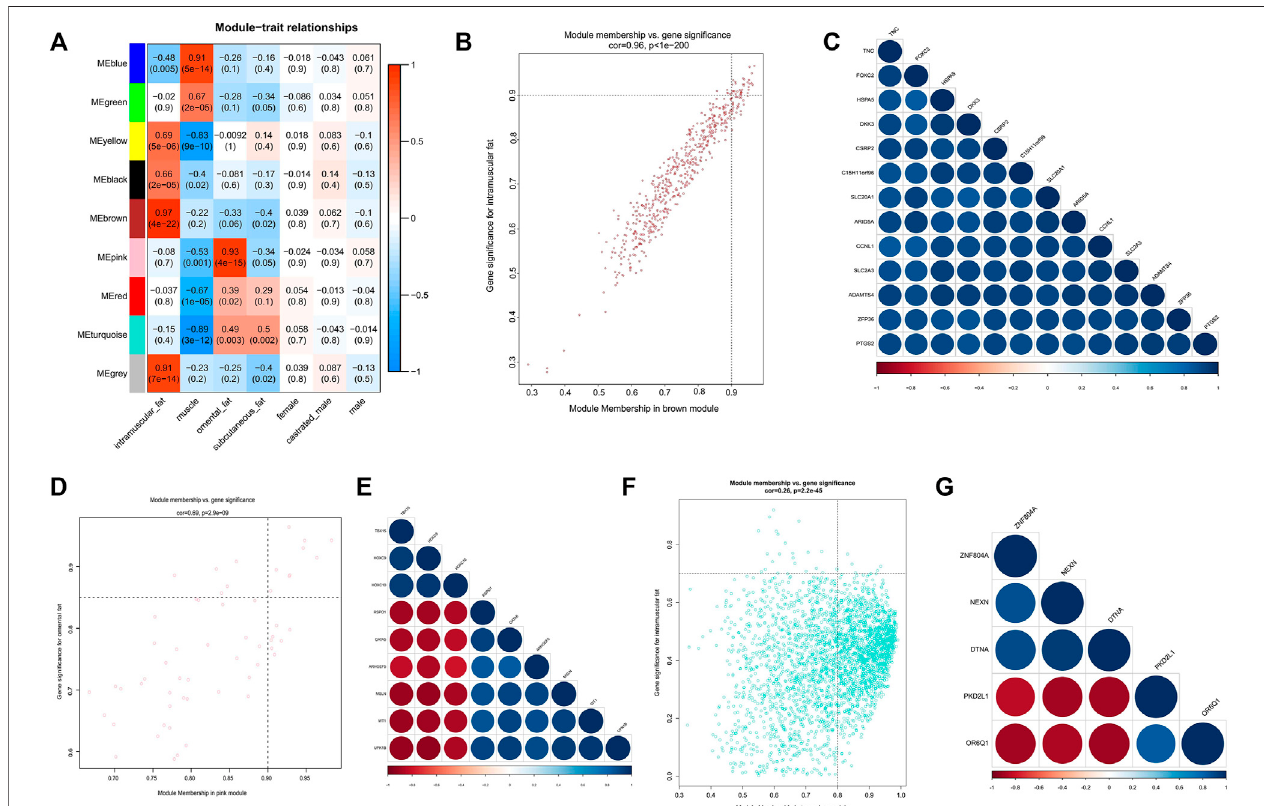
FIGURE 3 | Module-trait correlations analysis of GSE39618. (A) Correlation heatmap between modules and trait (correlation coef fi cient and p value are indicated); (B) The MM and GS for intramuscular fat in the brown module; (C) The correlation relationship of top 13 genes with high MM and GS in the brown module; (D) The MM and GS for omental fat in the pink module; (E) The correlation relationship of top 9 genes with high MM and GS in the pink module; (F) The MM and GS for inter-ribs subcutaneous fat in the turquoise module; (G) The correlation relationship of top 5 genes with high MM and GS in the turquoise module.